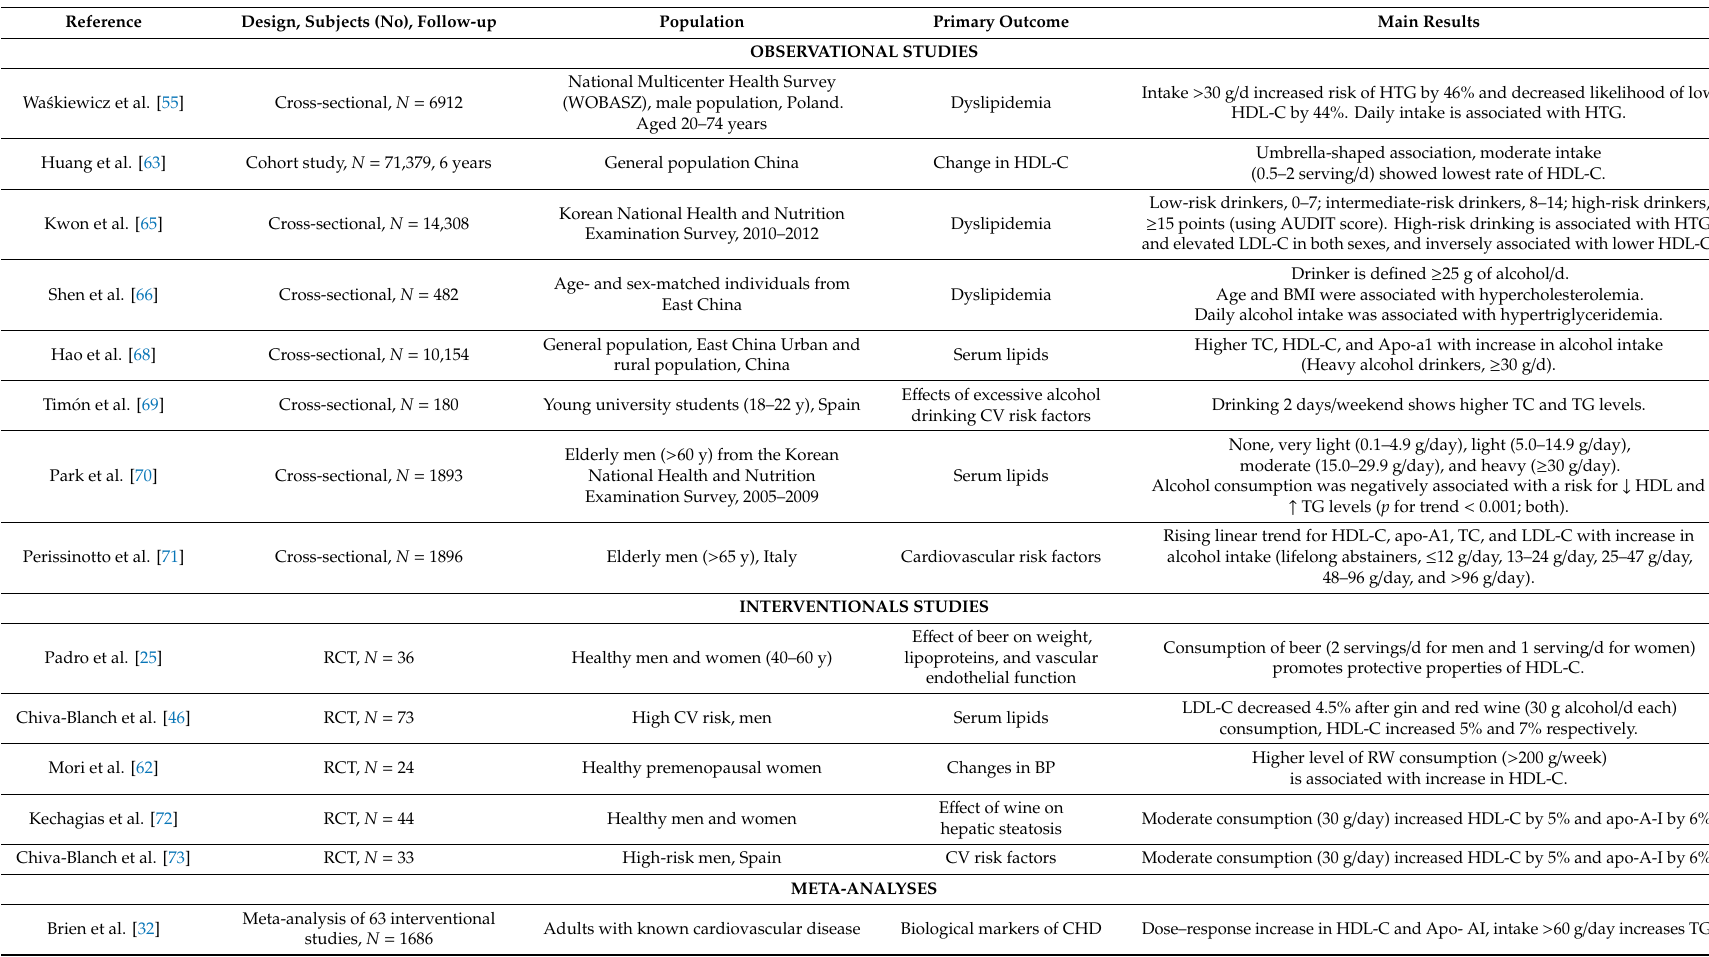
Table 3. Characteristics of 14 studies evaluating the e ff ect of alcohol on